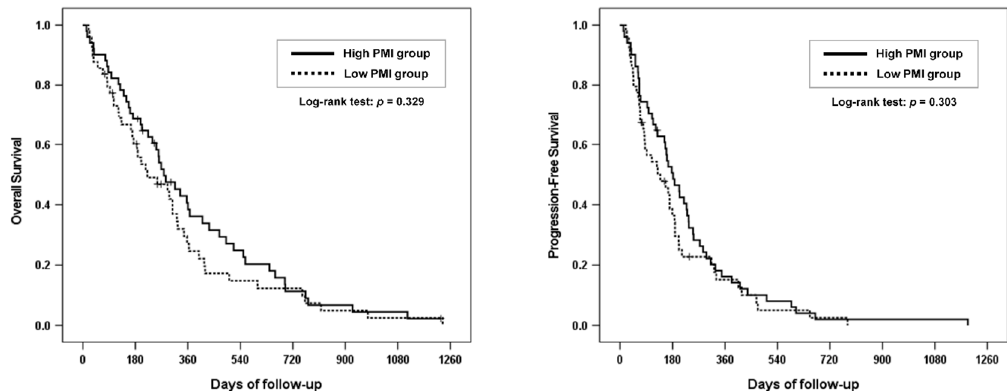
Figure 2. Overall survival and progression-free survival of the high- and low-PMI groups. PMI; psoas muscle mass index.